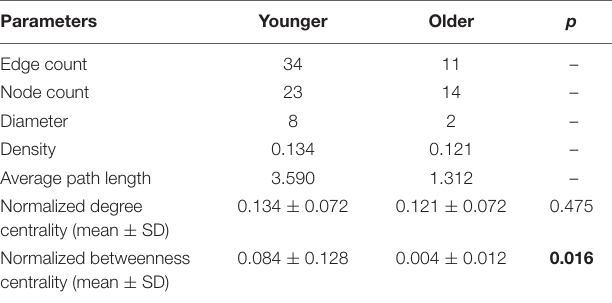
TABLE 2 | Topological properties of the OTU co-occurrence networks in younger (body length ≤ 8.4 cm, n = 10) and older (body length ≥ 9.8 cm, n = 11) groups of hibernating B. gargarizans